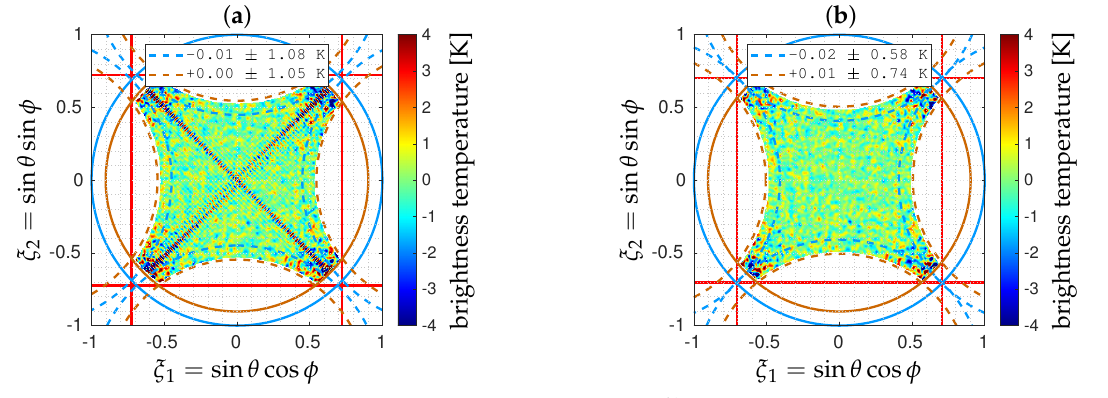
Figure 10. Average maps of 1000 error maps (cid:101) T − T obtained in X polarization with the cross-shaped array shown in Figure 4 for two values of the shortest spacing: ( a ) d = 0.69 λ and ( b ) d = 0.71 λ (similar results are obtained in Y polarization). In every case, complex visibilities V have been blurred by an additive Gaussian noise ∆ V with standard deviation set to 0.1